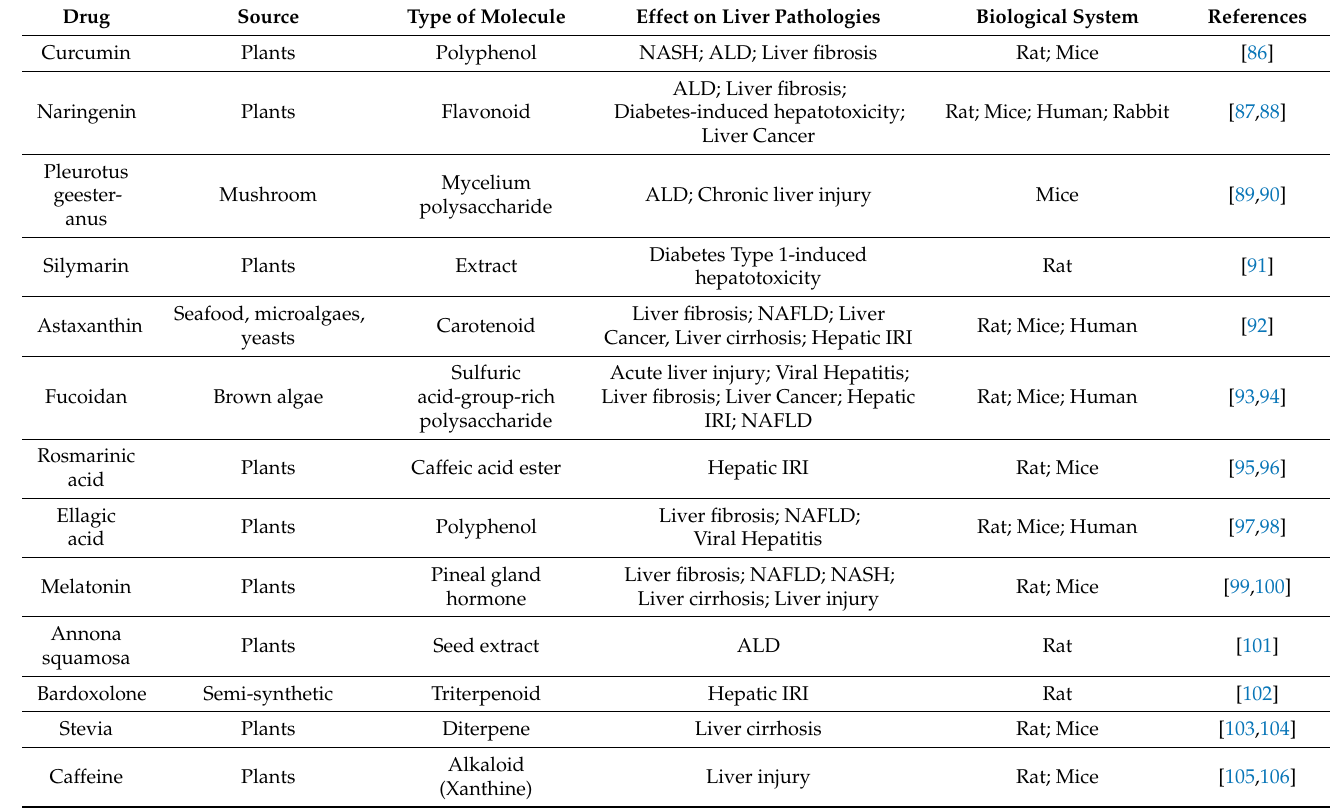
Table 1. List of the antioxidant compounds which induce Nrf2 pathway and its effect on liver